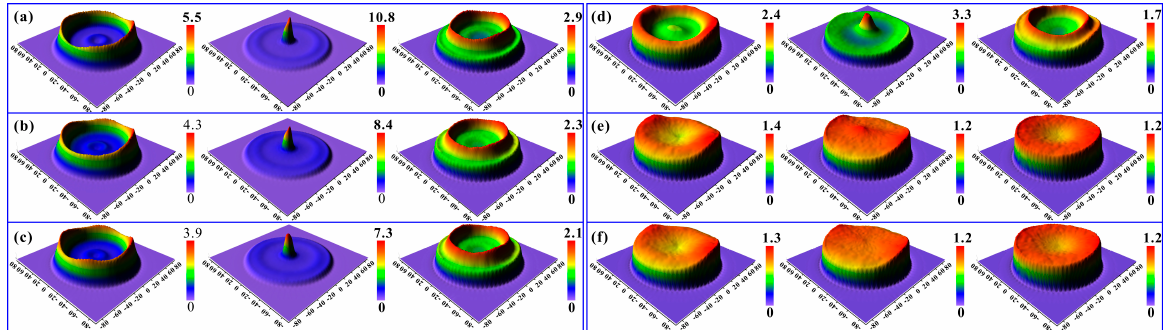
Figure 4. Pole figures of the Ni-SiC composite coatings assembled from Watts’ bath with ( a ) 0, ( b ) 10, ( c ) 20, ( d ) 80, ( e ) 160, and ( f ) 250 g/L SiC